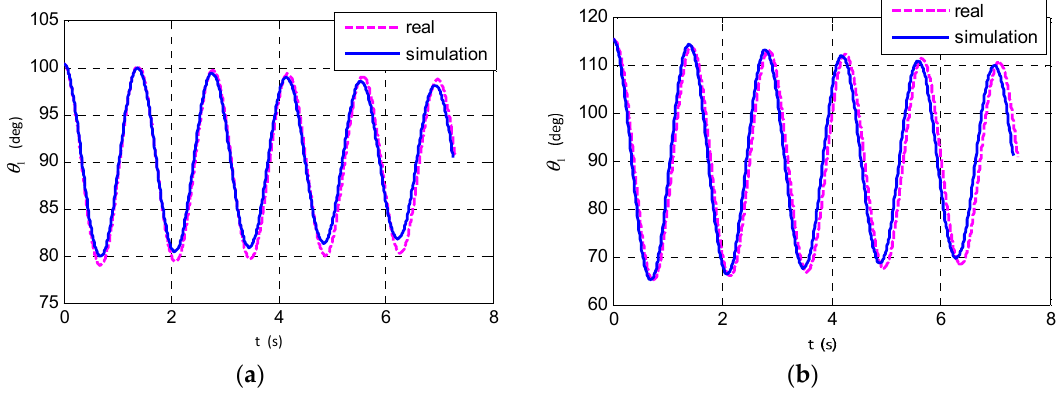
Figure 4. A simulation (blue solid curve) of the two-link model and the experimental result (red dashed curve) of the MonkeyBot with same damping coefficients and two different initial heights: ( a ) c = 0.0185, θ 1_0 = 100 ◦ and ( b ) c = 0.0185, θ 1_0 = 115 ◦ .